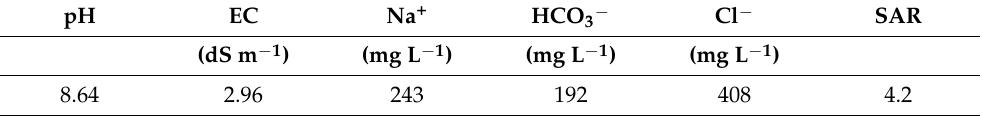
Table 1. Physicochemical characteristics of the irrigation water used in the experiment.